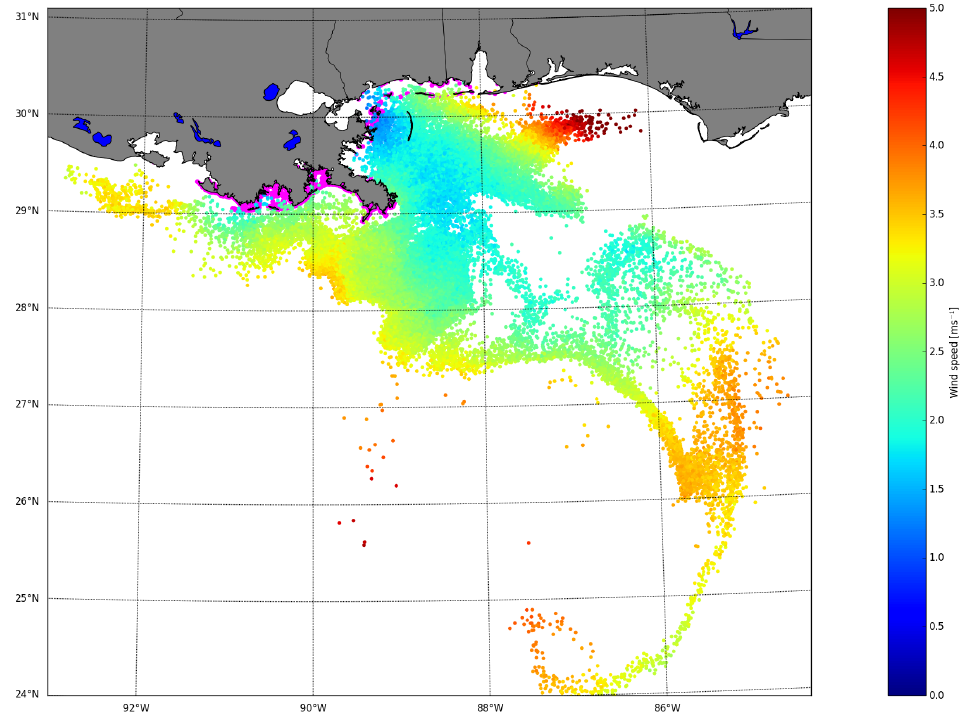
Figure 8. Same as Figure 7, but the color scale shows the average wind speed experienced by the element during the last 12